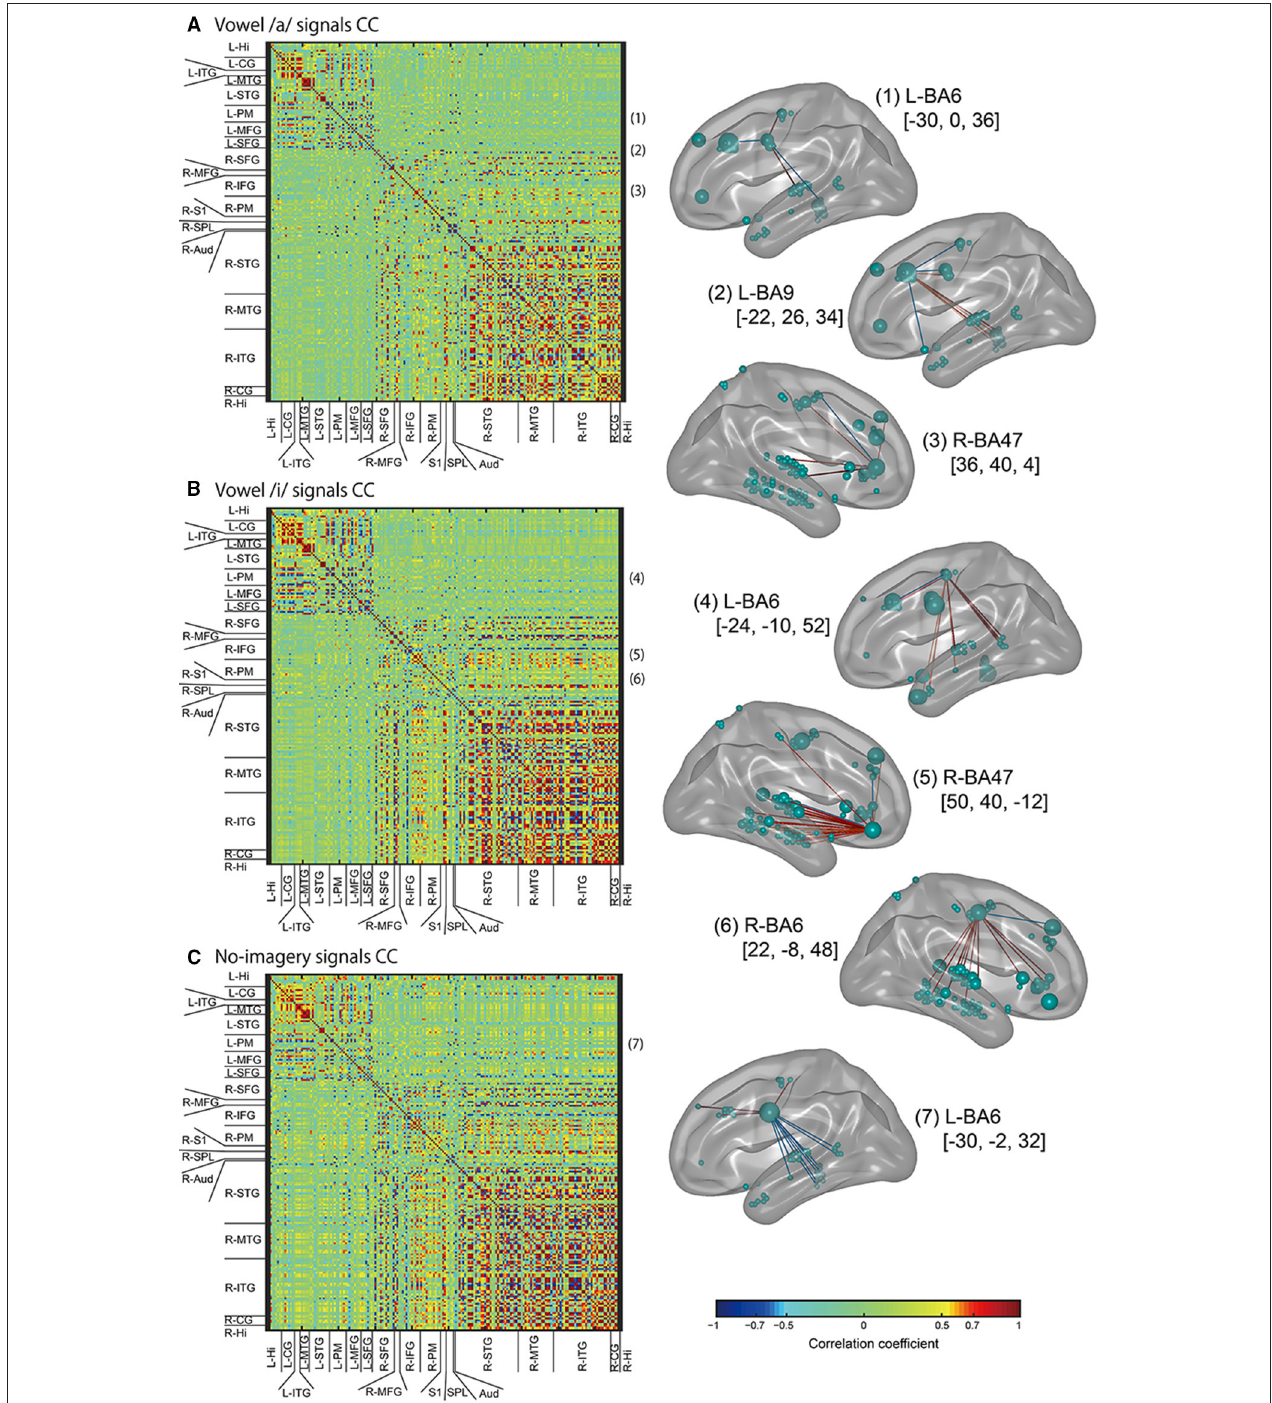
FIGURE 9 | Left panel: Color maps of correlation coefficient (CC) values for EEG cortical current signals. ROIs names that cortical vertices were included in are listed along with the horizontal and vertical axes. CC values were calculated for all tasks signals: vowel /a/ (A) , vowel /i/ (B) , and no-imagery (C) . Right panel: The FSHV-vertices defined in Figure 6 [(1–7) in this figure) were set as seeds, and positive correlations above 0.6 (red lines) and negative correlations below–0.6 (blue lines) were visualized with BrainNet Viewer (Xia et al., 2013) (http://www.nitrc.org/projects/bnv/). Green balls on the brain maps denote vertices, with their sizes representing mean weight values, and names of the brain areas in Brodmann style and MNI coordinates of the seeds are written besides the brain maps.